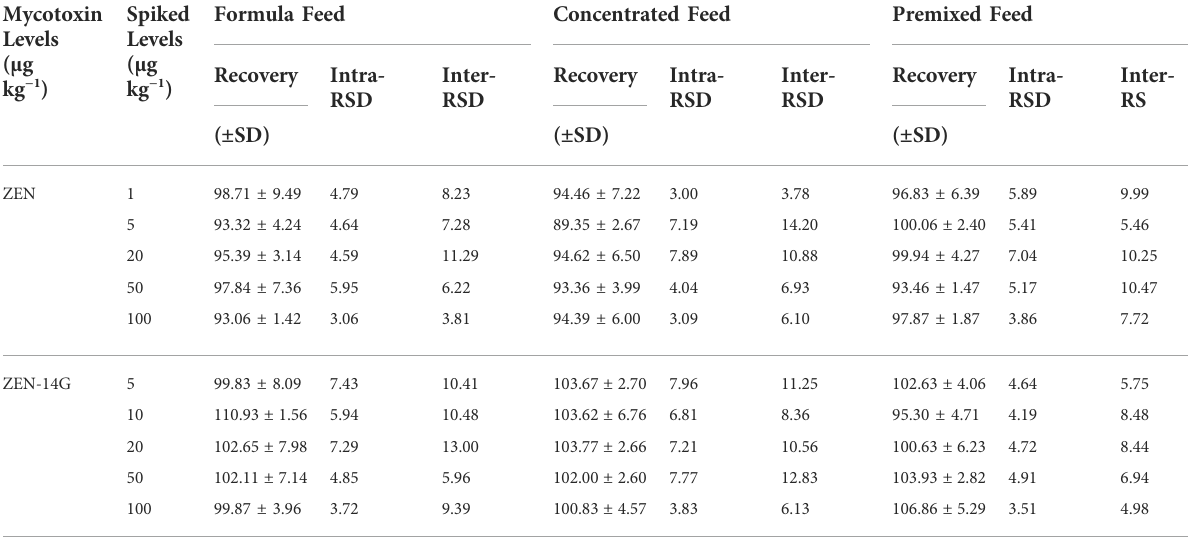
TABLE 3 Recoveries, intra-day, and inter-day precisions of ZEN and ZEN-14G in various feed matrices (%, n = 5). Mycotoxin Levels